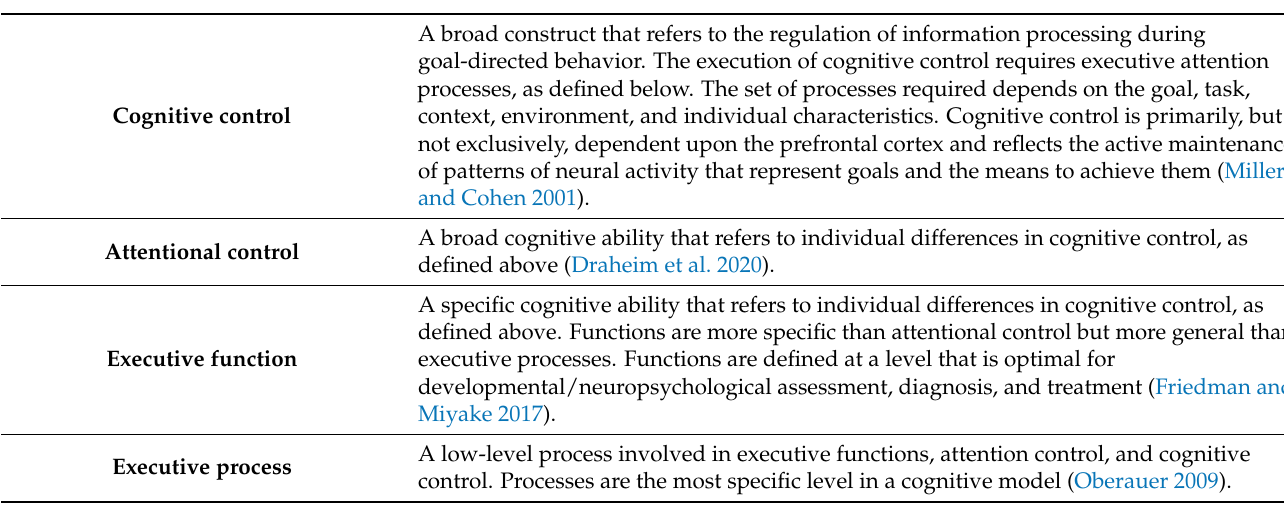
Table 1. Glossary of common